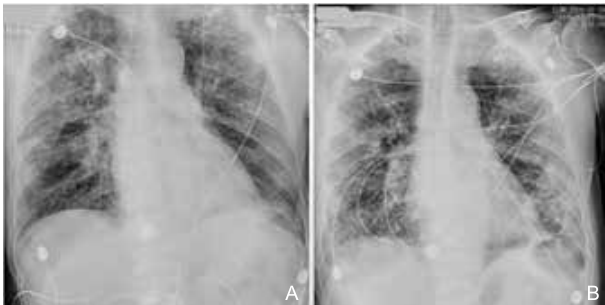
Figure 3 Recovery stage case plain films of a 68-year-old hospitalized male patient 14 days after disease onset. (A) The first radiograph showed widely distributed of fuzzy grid shadows in bilateral lungs and patchy density shadows in the right upper lobe; (B) On 4th day, the image showed that the lesions in the right lobe were mostly absorbed, while a new stripe high-density shadow and a new patchy high-density shadow were observed in the left lower lobe.